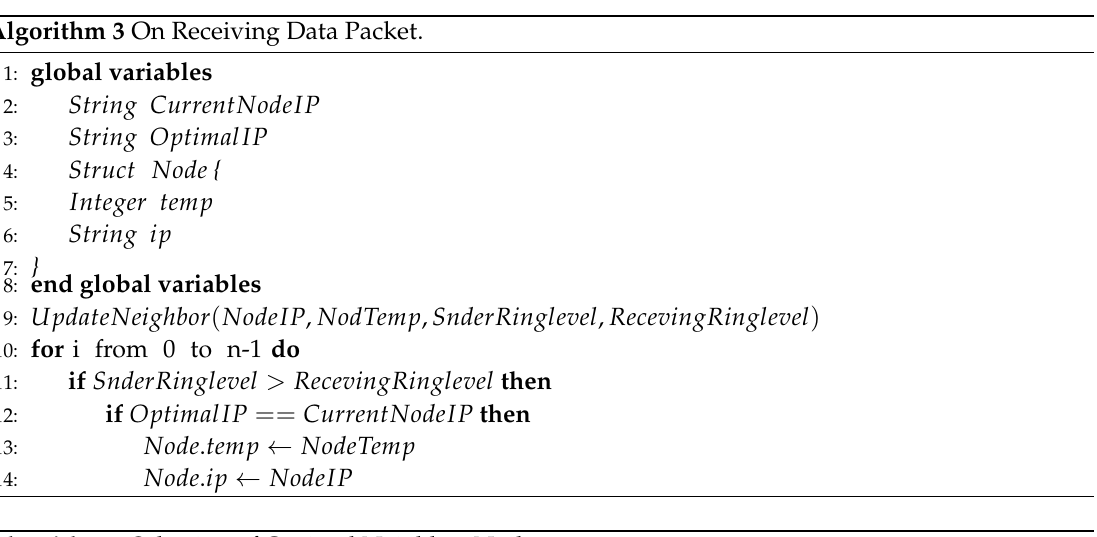
Algorithm 4 Selection of Optimal Neighbor